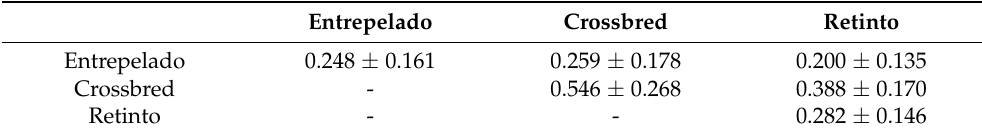
Table 2. REML estimates ± standard error (SE) of the additive genotypic (co)variances for the total number born (TNB).